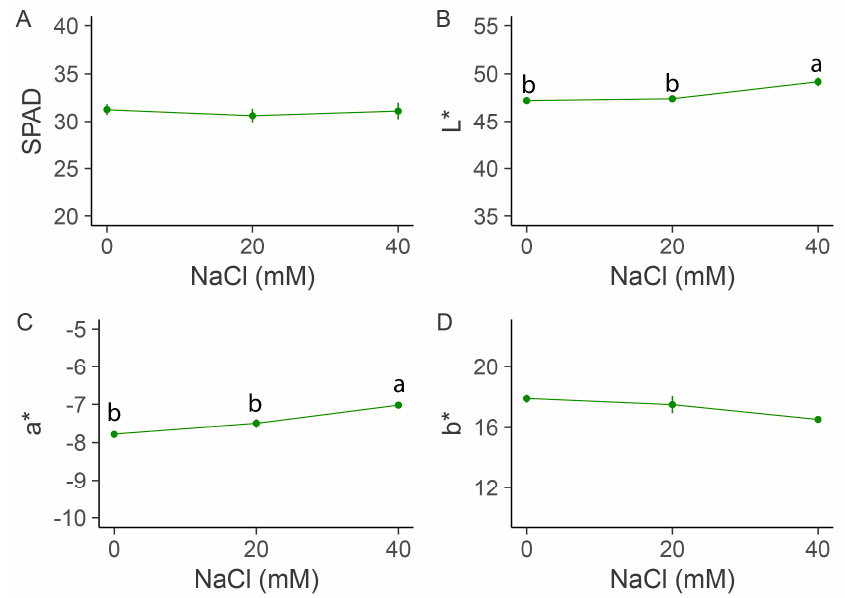
Figure 2. Effects of the NaCl in the nutrient solution on SPAD index and the L*, a*, and b* color coordinates according to the CIELAB standard: ( A ) SPAD; ( B ) L*; ( C ) a*; ( D ) b*. Data are mean ± standard error of the mean. Different letters indicate significantly different means according to the Tukey HSD test ( p < 0.05).